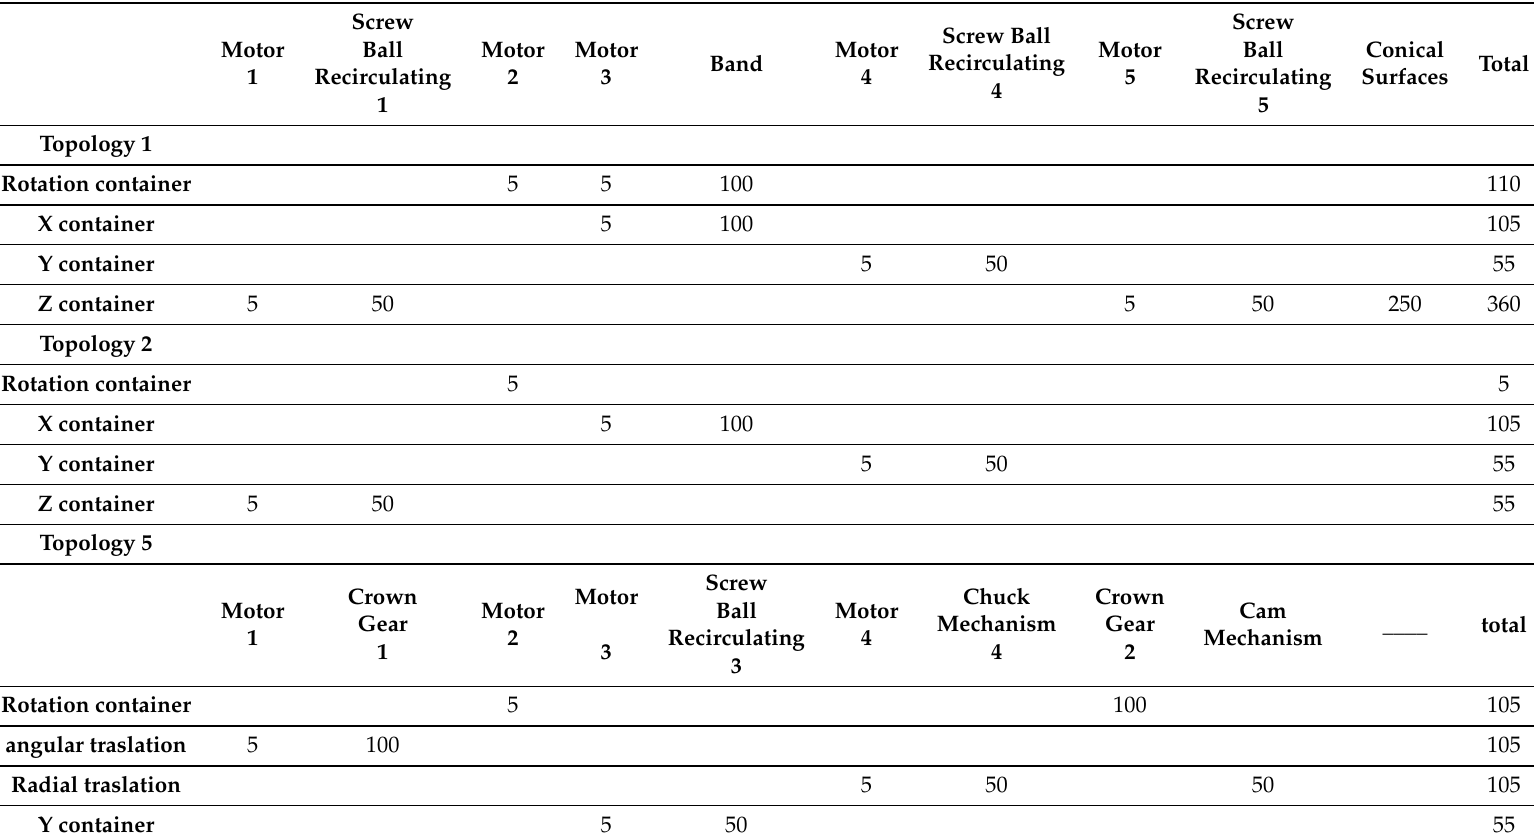
Table 1. Topologies Error [ µ